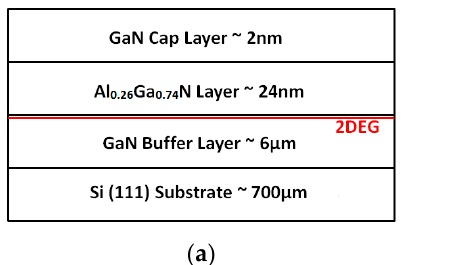
Table 1. Experimental parameters used in the oxygen furnace annealing process.